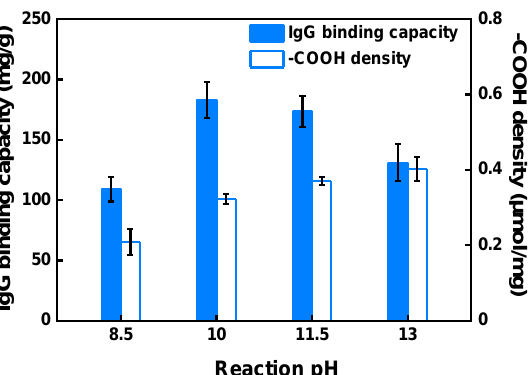
Figure 2. Influence of reaction pH for IDA coupling on IgG static binding capacity and -COOH density on CEX-IDA membranes. Preparation conditions: polyGMA grafted at 15% WG, IDA coupling for 7 h at 60 ◦